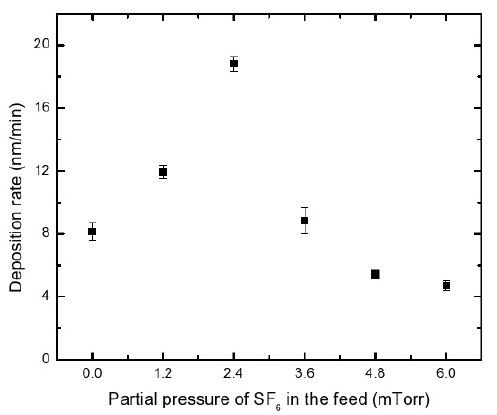
. Film thicknesses (nm) SF : 245, 358, 564, 265, 163, 141. SF